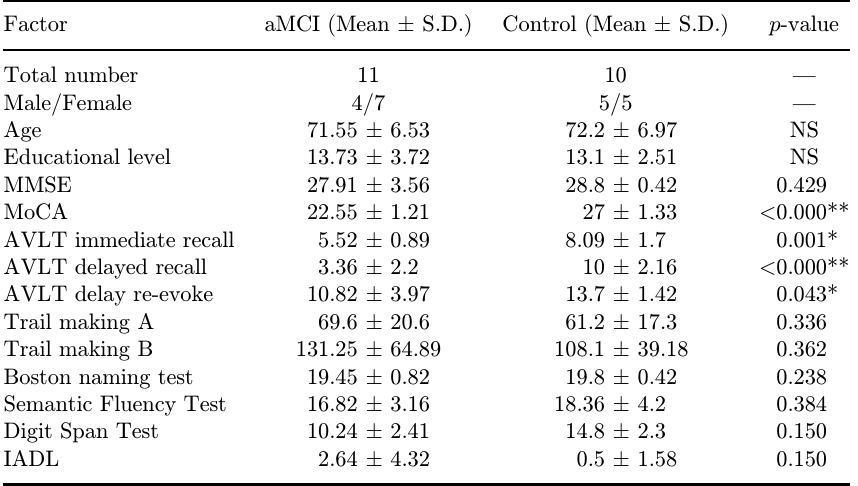
Table 1. Demographic and neuropsychological characteristics in the aMCI group